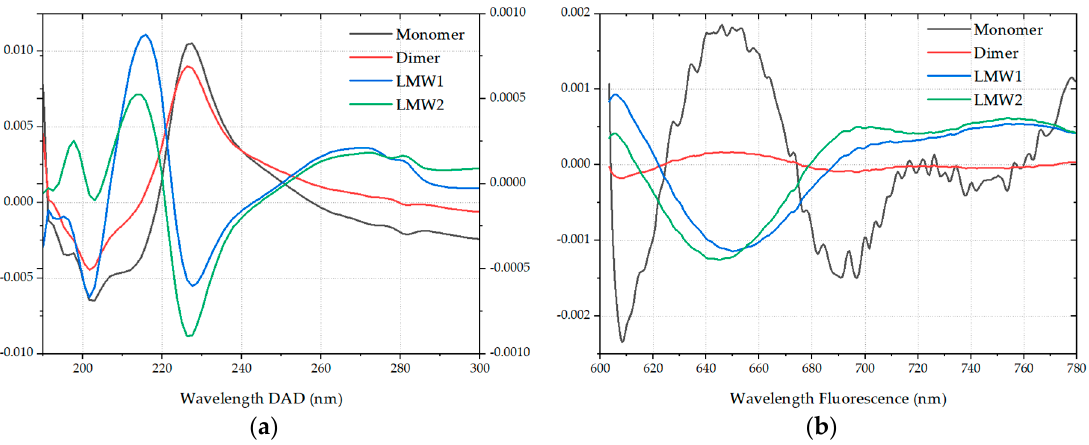
Figure 12. Regression coefficients for DAD ( a ) and fluorescence ( b ) for correlated wavelengths.